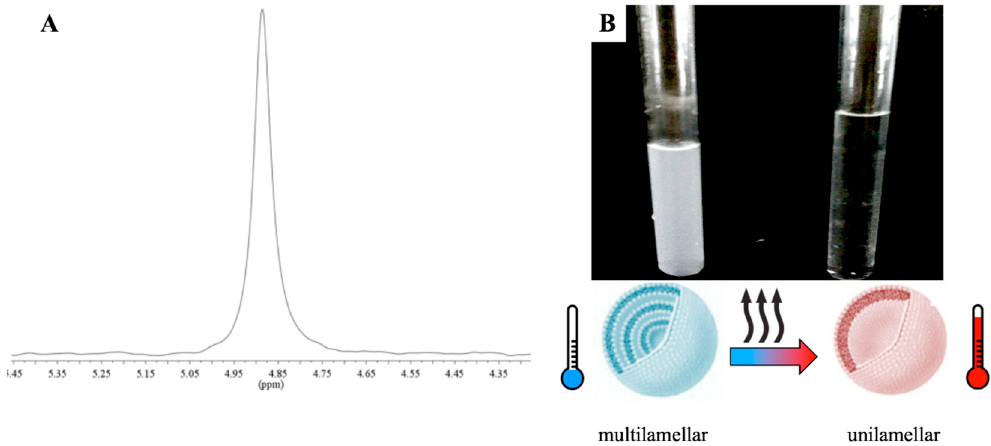
Figure 1. Multi-to-unilamellar vesicles thermal transition . ( A ) 2 H-NMR spectrum of SDS / CTAB aqueous solution and ( B ) decrease of turbidity with heating.